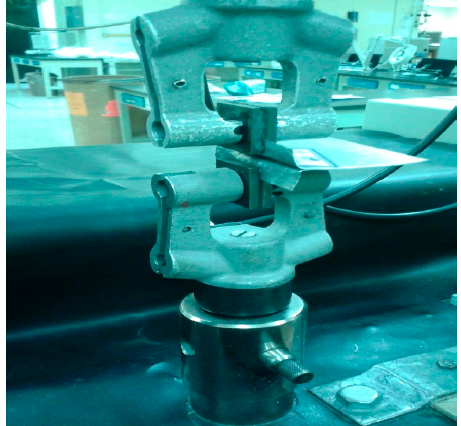
Figure 4. Schematic illustration of the peeling test fixture.